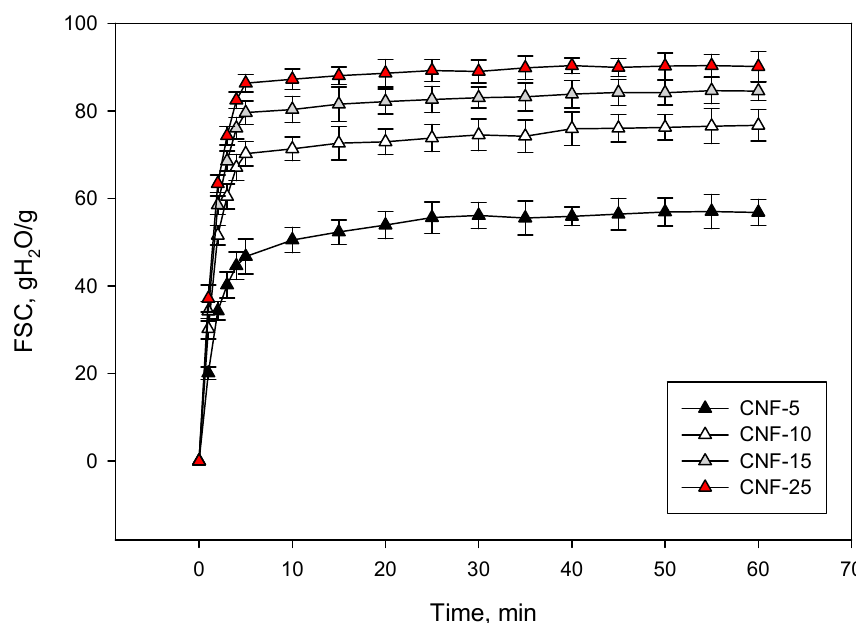
Figure 5. Evolution of free swelling capacity (FSC) as a function of immersion time (in minutes).